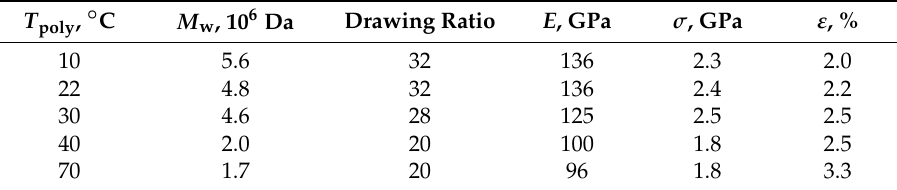
Table 3. Mechanical properties of UHMWPE oriented film tapes.